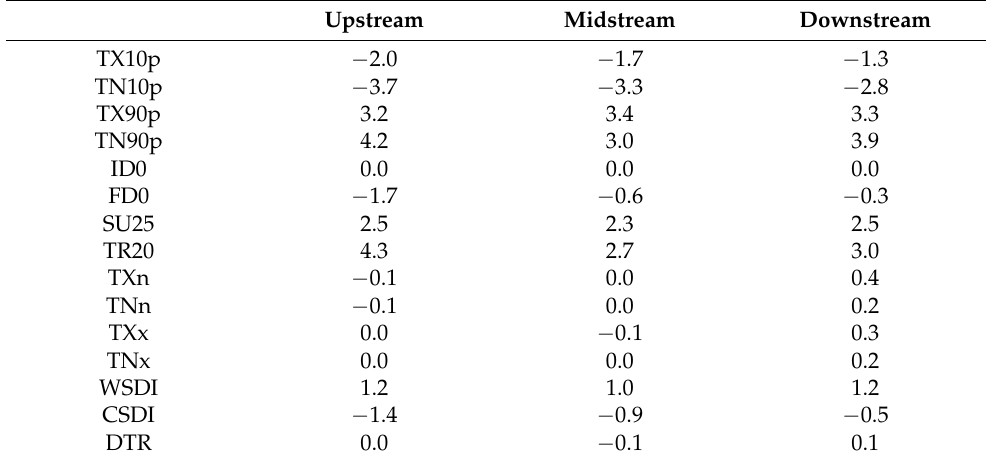
Table 4. Temporal trends of extreme temperature indicators in the Qingyi River basin.